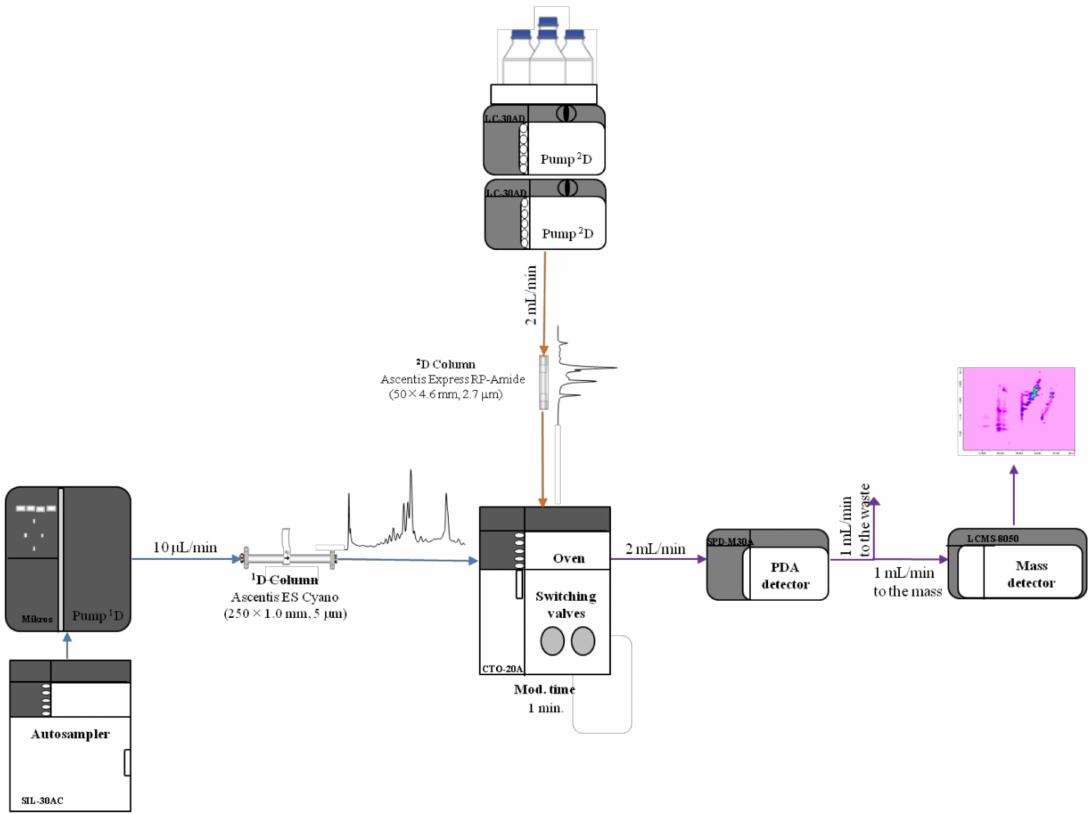
Figure 1. Scheme of the reversed-phase liquid chromatography RP-LC × RP-LC system employed